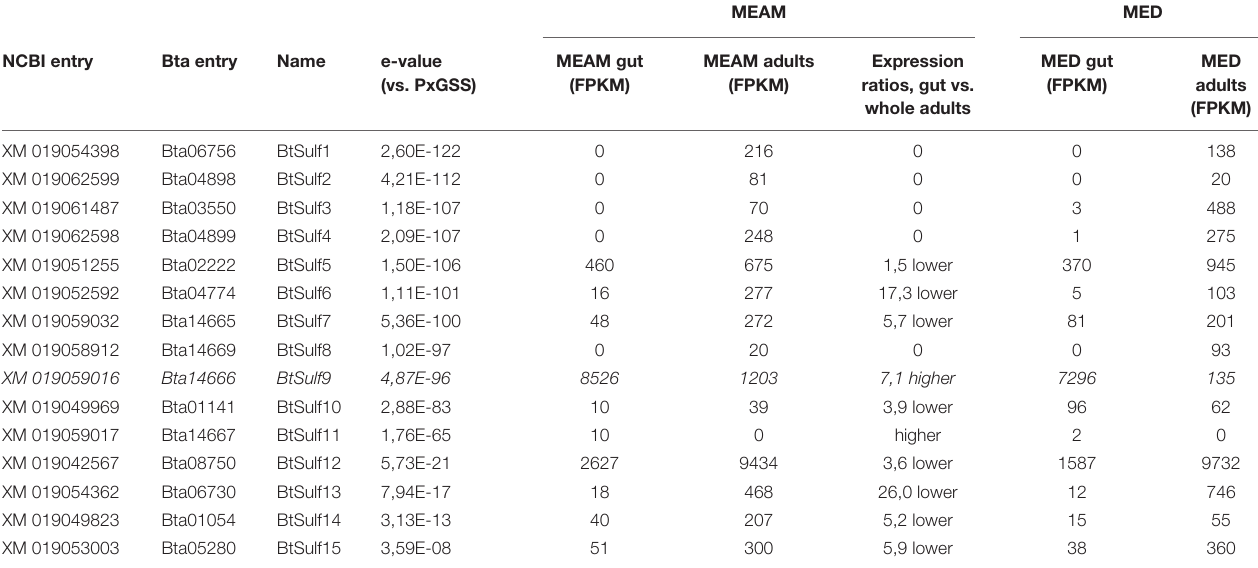
TABLE 1 | Predicted Bemisia tabaci sulfatase (“BtSulf”) candidates, ordered based on sequence similarity scores (e-values) to Plutella xylostella GSS (PxGSS).